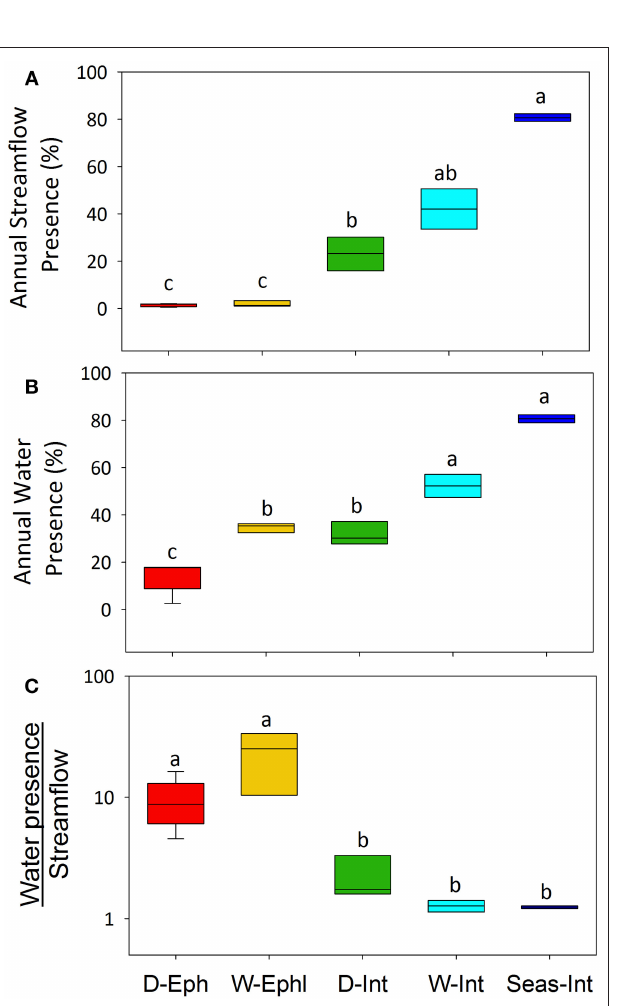
FIGURE 5 | Box plots of (A) Percent annual streamflow; (B) Percent annual water presence and (C) ratio of water presence to streamflow across clusters. Box plots sharing a lowercase letter are not significantly different ( p >